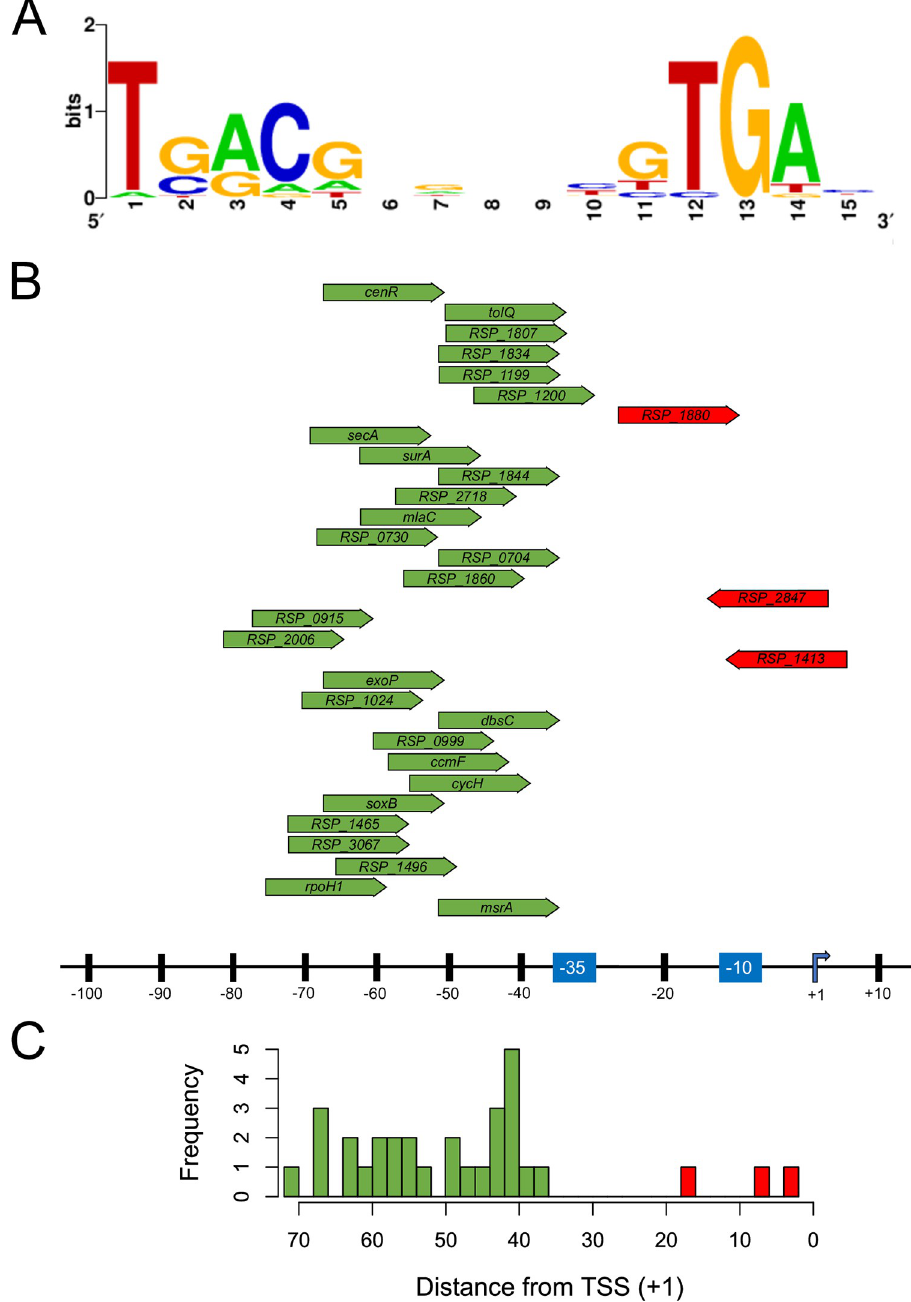
Fig 4. Identification of the CenR DNA binding motif. (A) WebLogo [134] representation of CenR consensus sequence determined using the MEME motif finder. Of the 59 promoters identified in ChIP-seq experiments, 31 operons contained the putative CenR consensus sequence TGA-(N8)-TGA. (B) Location and orientation of the 31 identified CenR binding sites, in respect to the previously determined TSS [41] and promoter -35 and -10 elements [126] for directly activated (green) and repressed (red) transcription units. The DNA sequence of each binding motif is listed in Table 1. (C) Histogram of the distance from the center of each putative CenR binding site and the TSS of the respective transcription unit mapped in (B). Operons predicted to be activated have CenR binding sites upstream of the -35 promoter element, whereas operons predicted to be repressed have CenR binding sites that overlap either the TSS or the predicted promoter